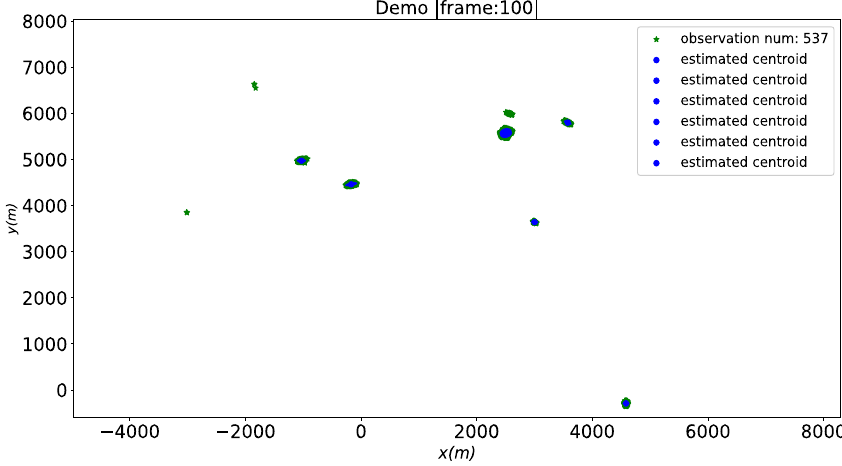
Figure 24. Multi-target tracking in the Cartesian coordinate system in the 100th frame.